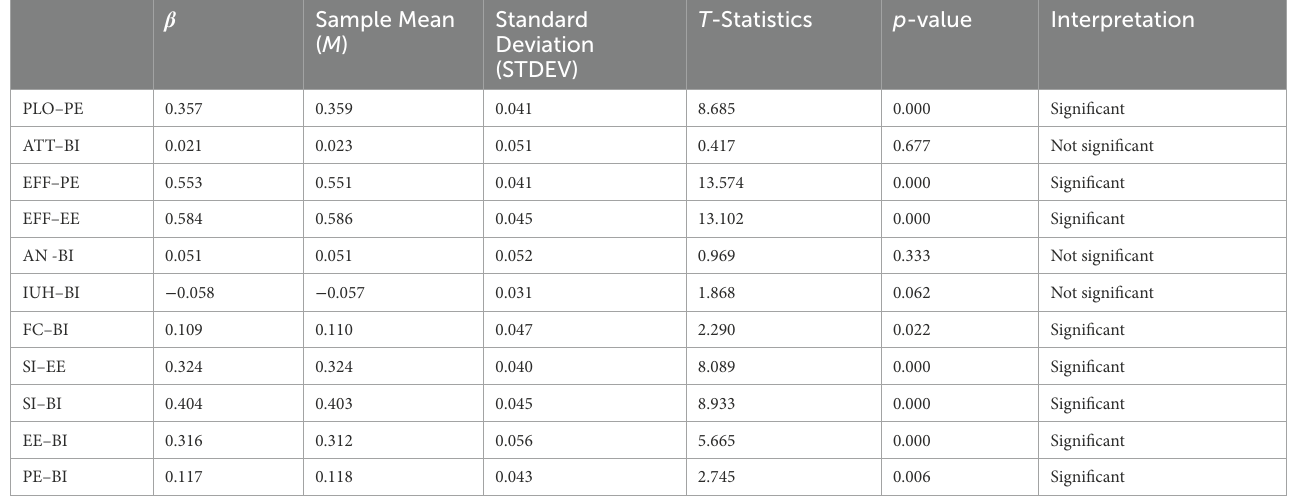
TABLE 7 Bootstrapping results.